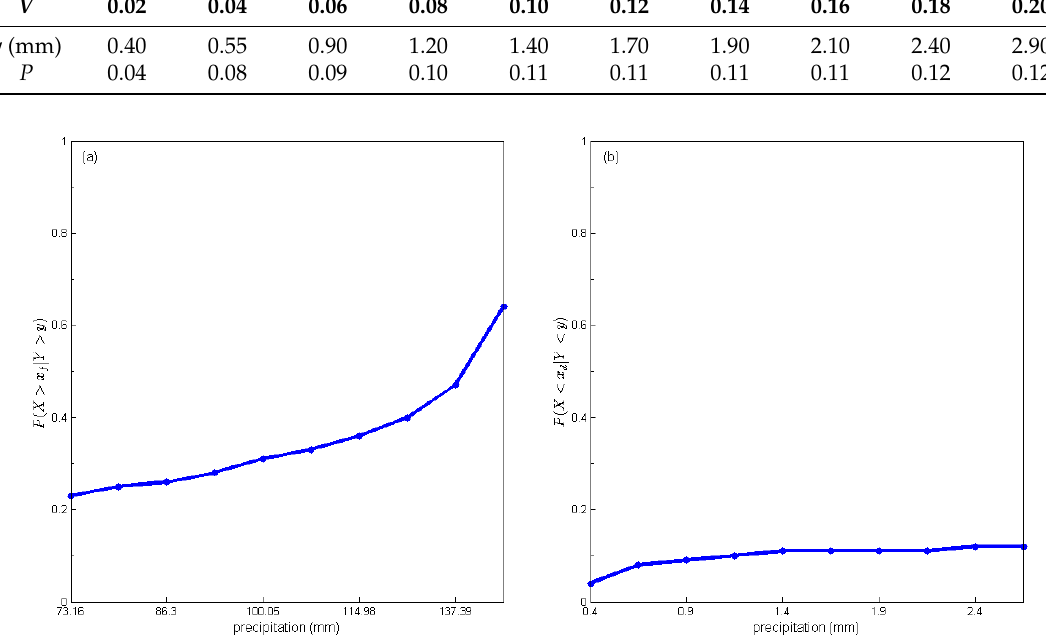
Figure 9. The conditional probabilities of large and small discharge at different precipitation levels. ( a ) conditional probabilities of large discharge, ( b ) conditional probabilities of small discharge Table 4. The conditional probability that